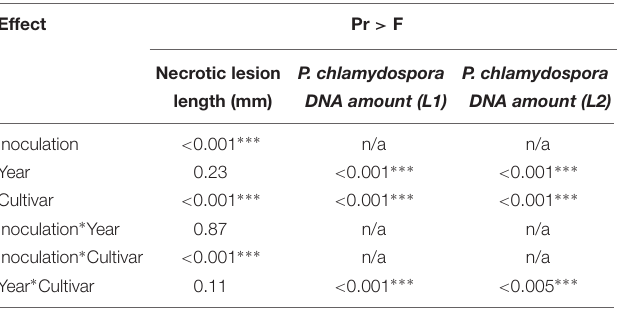
TABLE 1 | Analyses of variance (ANOVA) showing the effect of inoculation, year, grape cultivar and their interactions for the in planta resistance bioassay. Effect